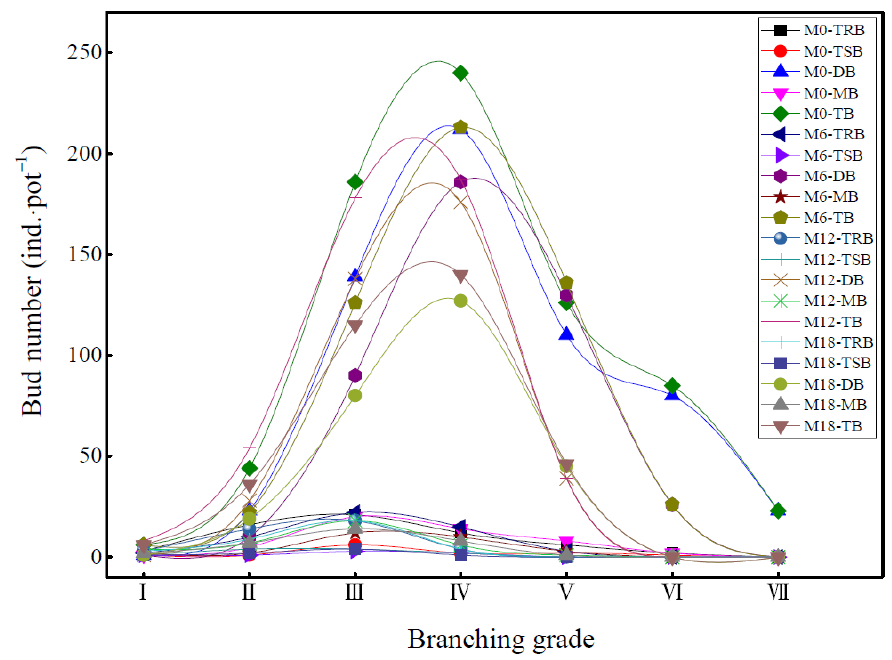
Figure 7. Variation trend of rhizome bud bank.